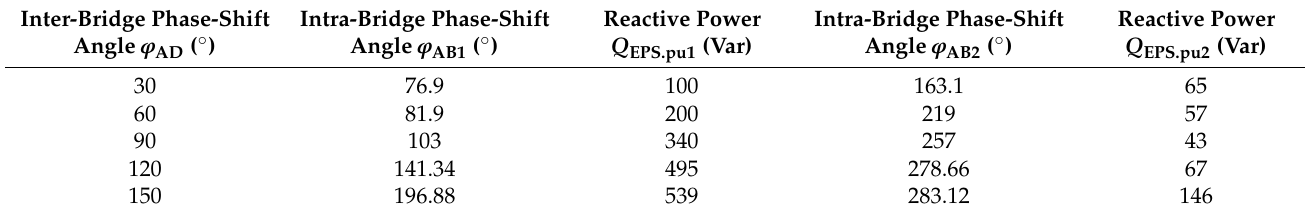
Table 2. Comparison of reactive power values at different phase-shift angles.